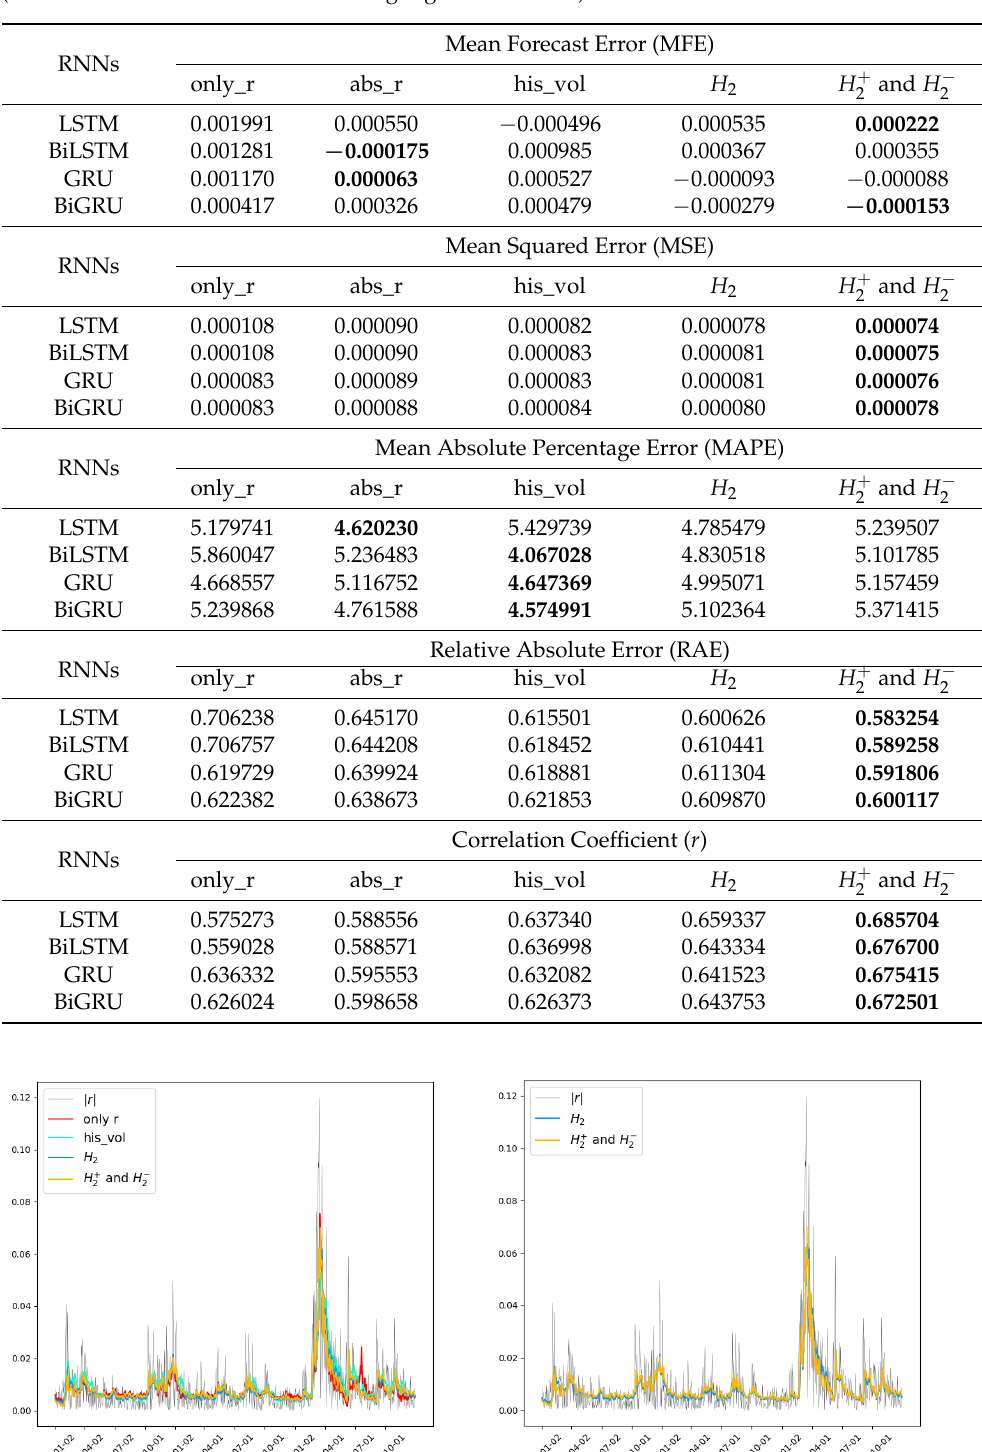
Table 3. Forecasting the performance of four RNN models with different inputs from 2018 to 2020 (Please note that: the best results are highlighted in BOLD ).